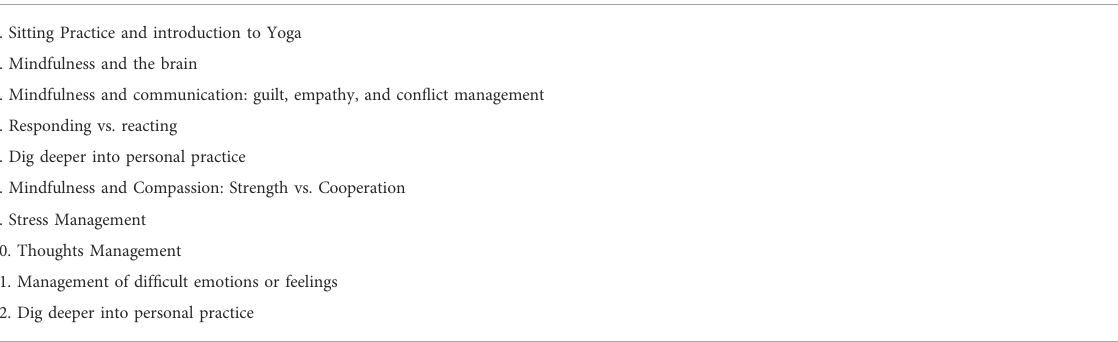
TABLE2( Continued )ContentsoftheFIBROWALKprogram(i.e.,PainNeuroscienceEducation,TherapeuticExercise,CognitiveBehavioralTherapy,and Mindfulness Training). Pain neuroscience education